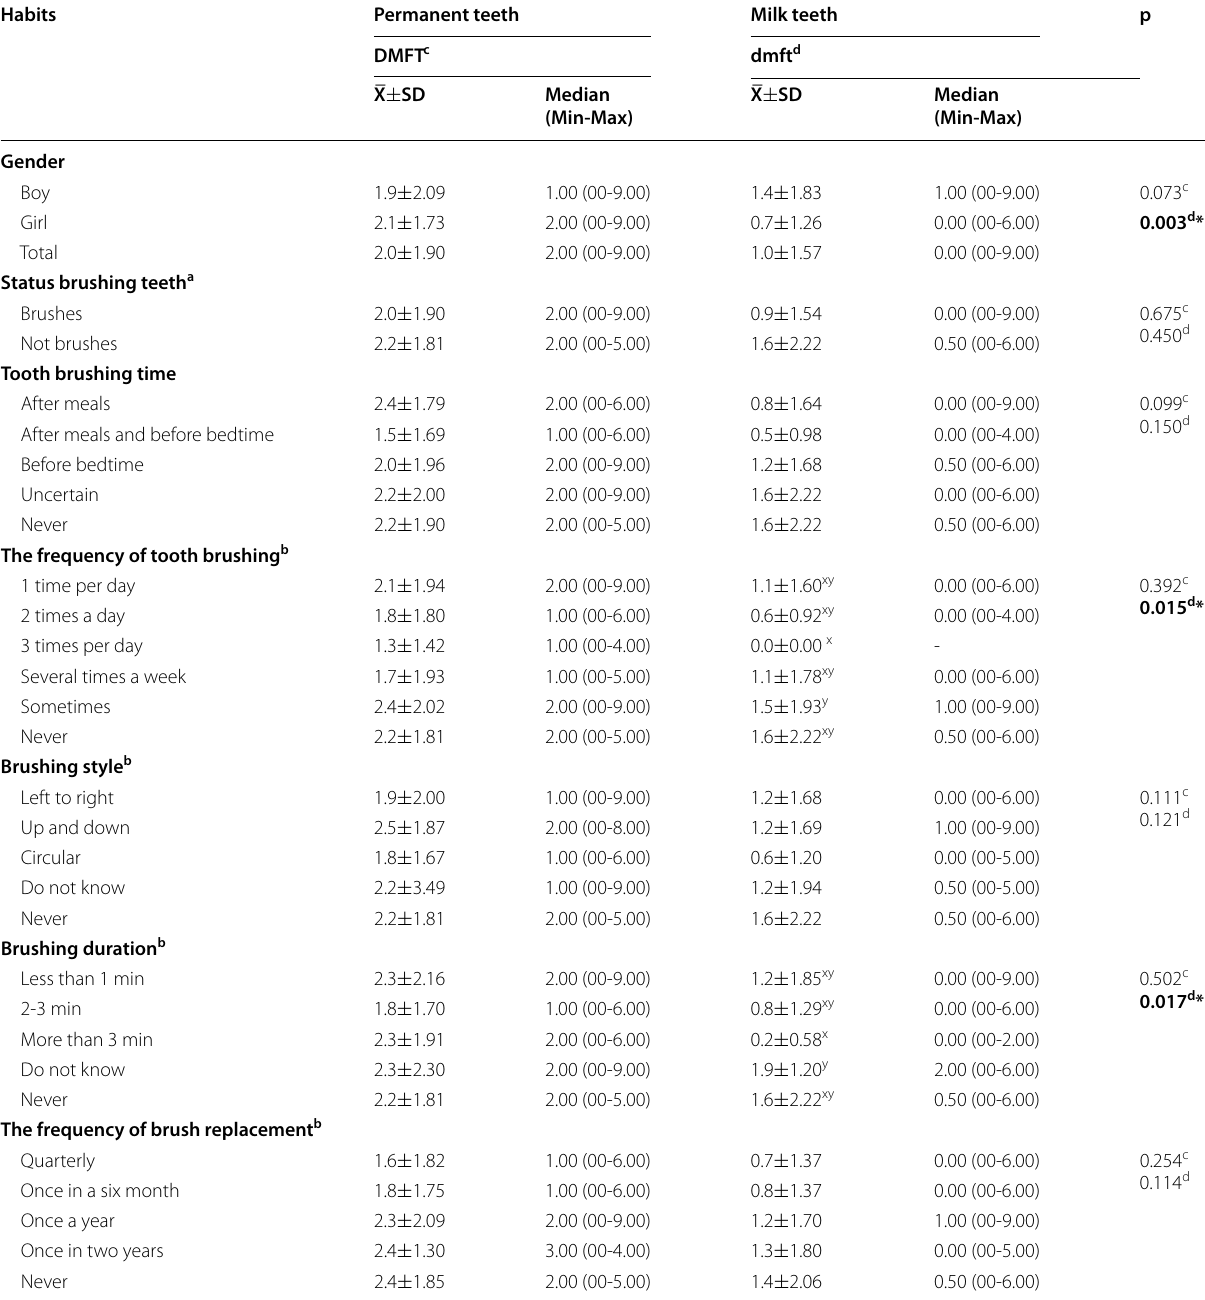
Table 3 Oral Health Indicators According To Gender and Oral/Dental Health